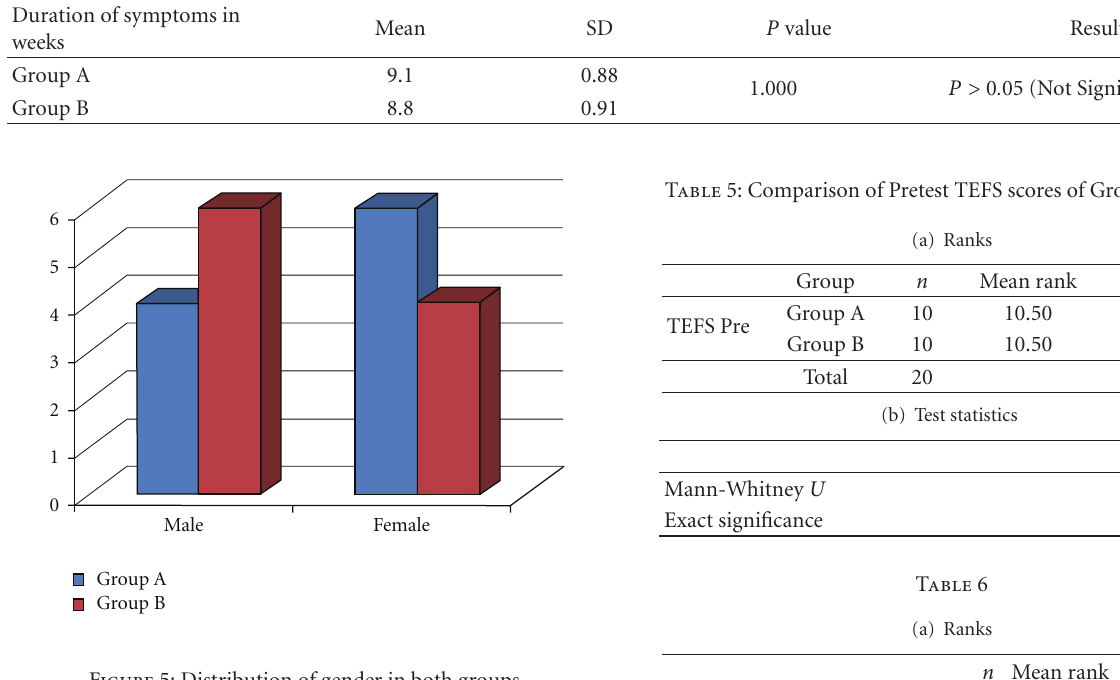
Figure 5: Distribution of gender in both groups.